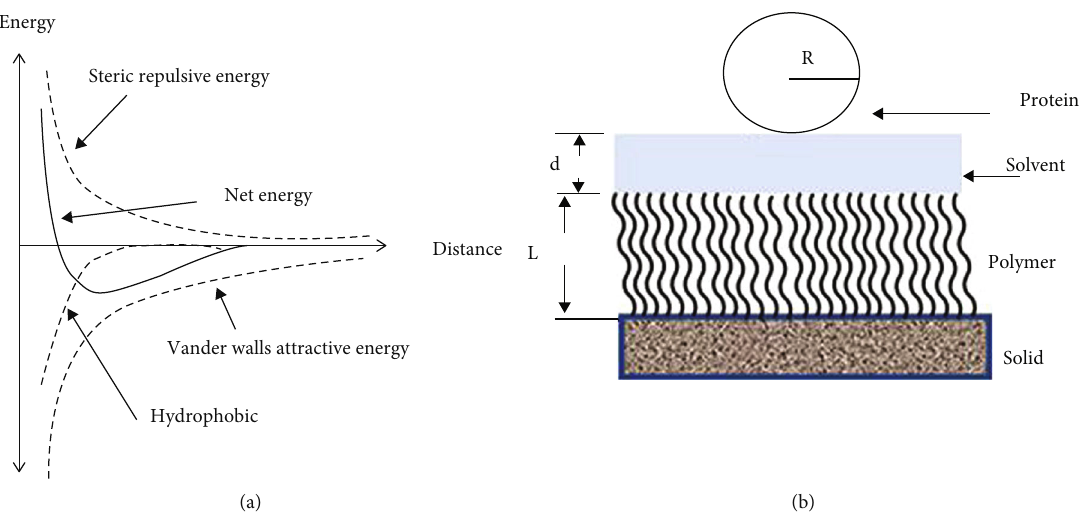
Figure 2: (a) A schematic of the interaction energies between the PNIPAM brush grafted onto a solid surface and the protein, and (b) is a schematic of the model used to determine the interaction forces